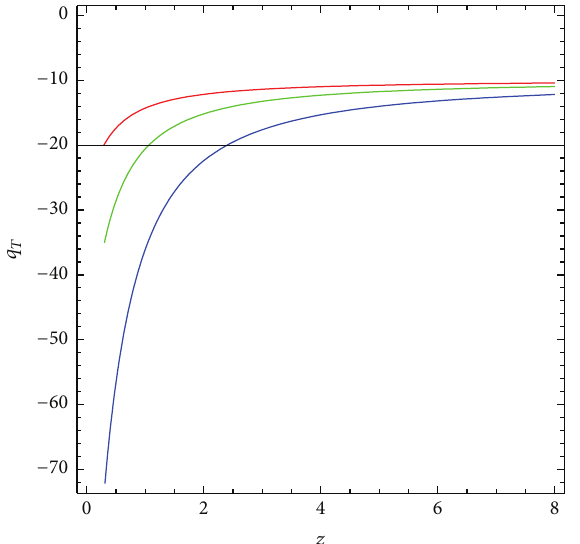
Figure 10: Statefinder parameters for the choice of 𝑓(𝑇) = 𝛼(−𝑇) 𝑏